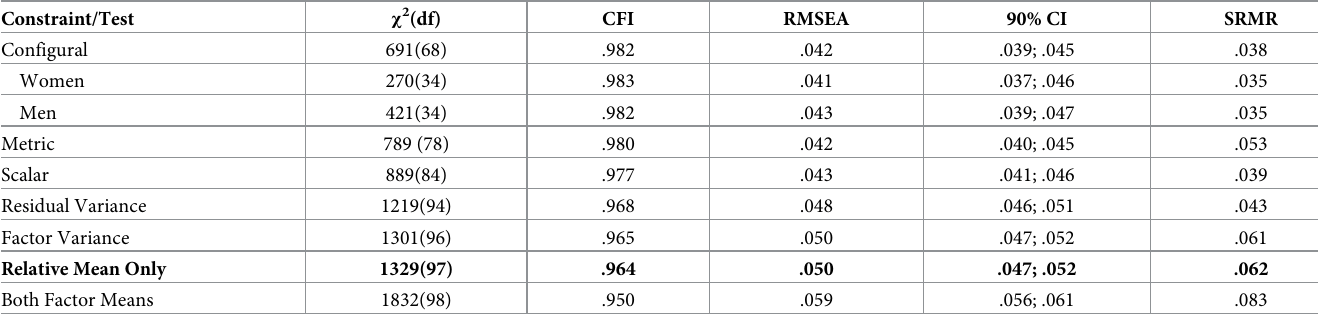
Table 4. Tests of measurement invariance and structural invariance (Study